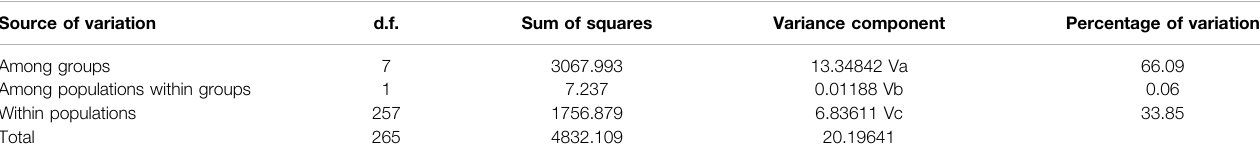
TABLE 4 | Spatial Analysis of Molecular Variance (SAMOVA) showing the percentage of genetic variation explained among groups (Moncul E, Lingue E, Colico L, Maullín E, Llanquihue L, Pichilaguna L, Quetru L, Pascua/Tortel E), among populations within groups and within populations using mtDNA. Where F SC represents differentiation within populations among groups and F CT represents differentiation among groups (*** p < 0.001, ** p <